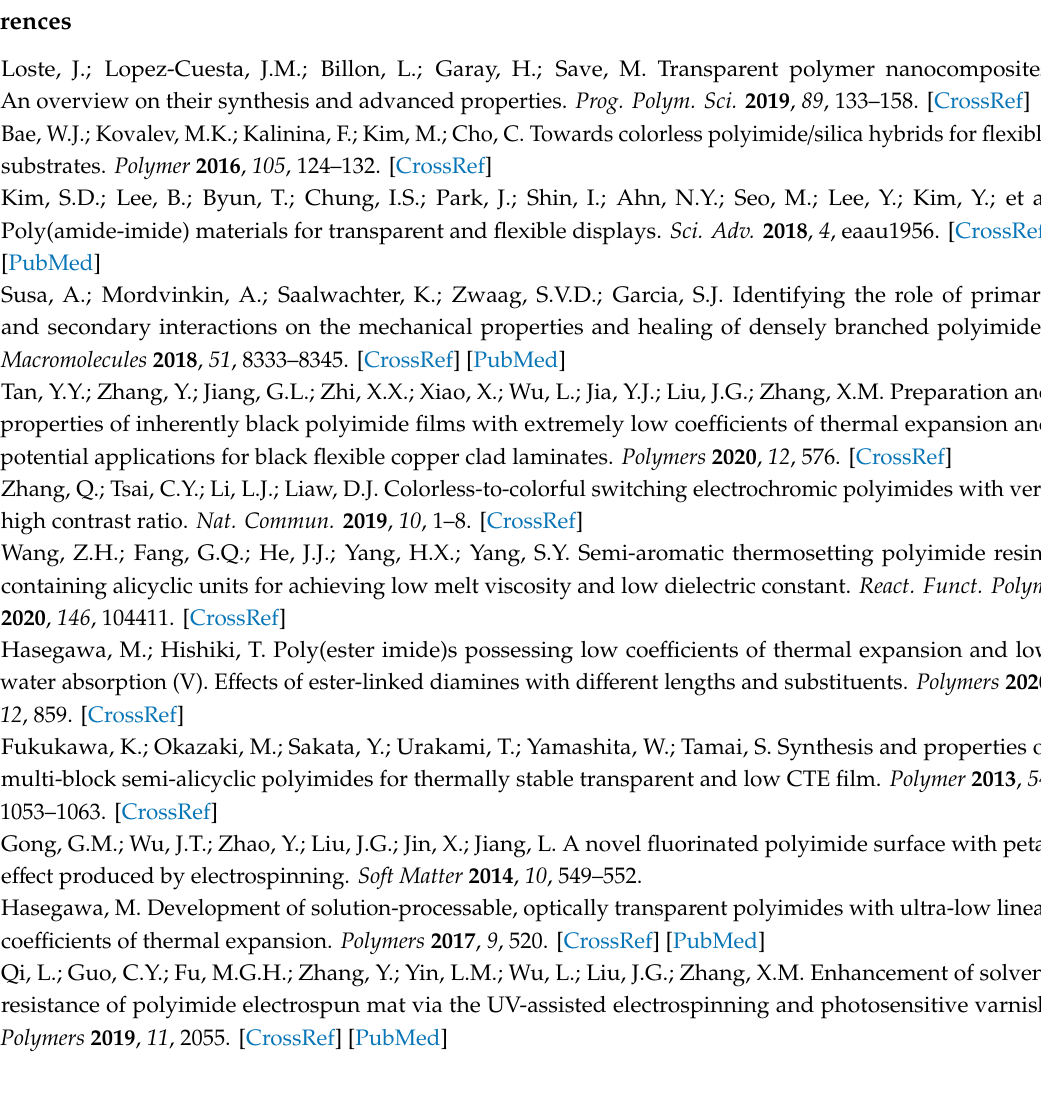
Figure S1: ATR-FTIR spectra of semi-alicyclic polyimide films., Figure S2: 1 H NMR spectra of the semi-alicyclic polyimides in in DMSO- d 6 , Figure S3: Scanning electron microscopy (SEM) images of the surface and cross-sectional fracture of PI-1 film, Figure S4: Water contact angle images of the semi-alicyclic polyimide films; Figure S5: DMA curves of semi-alicyclic polyimide films in nitrogen, Figure S6: TMA curves of semi-alicyclic polyimide films in nitrogen, Figure S7: Model compound structures of semi-alicyclic polyimides for the DFT calculations, Table S1: Representative structures and performance comparison of di ff erent semi-alicyclic polyimides prepared in the present and previous